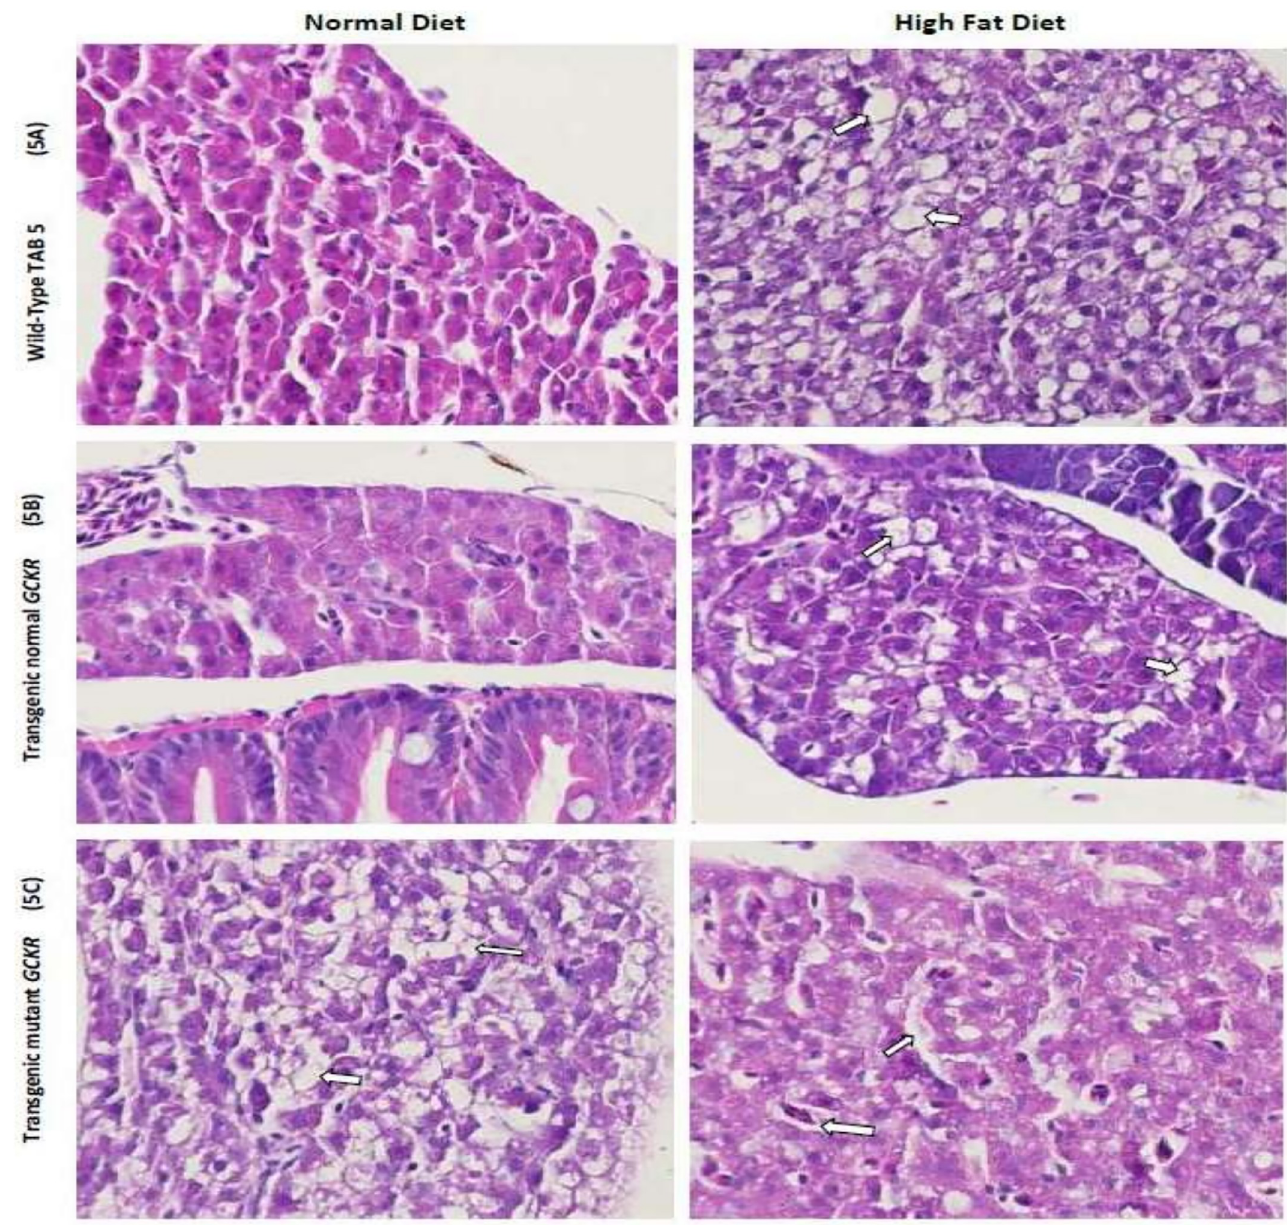
Fig 5. A-C . Fig 5A. Zebrafish liver histology of Hematoxylin and Eosin stained sections showing cellular differences in normal and high fat feeding for 2 weeks. A. A wild-type Tab-5 liver with normal hepatic cells and HFD showing normal liver with scattered fat cells (white arrow) showing 3+ fat without apoptosis. Fig 5B. Transgenic normal GCKR with normal hepatocytes in larvae fed on normal diet and normal liver with scattered fat cells (white arrow) in transgenic larvae fed on HFD with no apoptosis. Fig 5C. Transgenic mutant GCKR with normal diet shows liver with fatty metamorphosis and scattered hepatic cell apoptosis (white arrow) with 4+ fat. Transgenic mutant GCKR with HFD shows 4+ fat with severe cellular damage and higher fatty infiltration than the normal and transgenic normal fish. Most hepatic cells also contain vacuoles of fat and there is severe disorganization of the hepatic